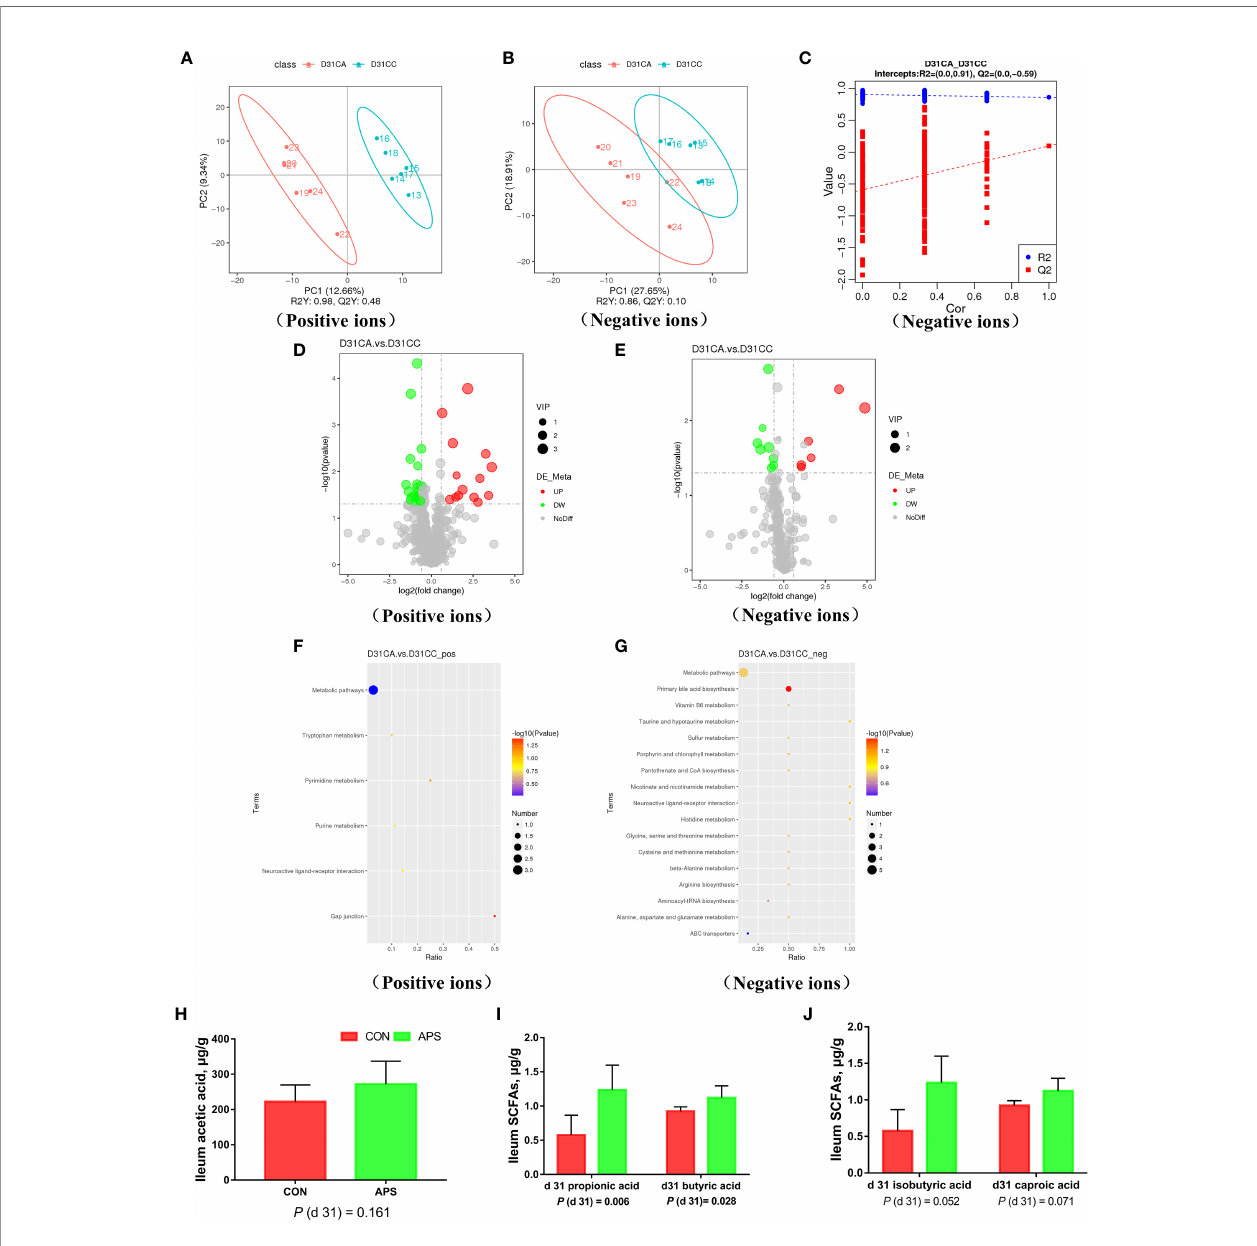
FIGURE 8 | Effects of dietary supplementation of astragalus polysaccharides on ileal metabolome and short-chain fatty acids of broiler chickens. PLS-DA scatter plot for group CA group vs. CC group (A, B) . Permutation test (C) of PLS-DA model for group CA versus CC (negative ion mode). Volcano plot for group CA versus CC (D, E) . Each point in the mountain chart represents a metabolite, the abscissa represents the fold change (take the log 2 logarithm) of each substance in the group, and the ordinate represents the P-value of the T test (take the log 10 logarithm). The size of the scatter points represents the VIP value of the PLS-DA model, and the larger the scatter point, the greater the VIP value. Scattered colors represent the fi nal screening results. Signi fi cantly up-regulated metabolites are shown in red, signi fi cantly down-regulated metabolites are shown in green, and non-signi fi cantly different metabolites are shown in grey. CA group versus CC group KEGG pathway enrichment analysis bubble chart (F, G) . According to the results of KEGG enrichment, select the top 20 pathways sorted by P-values from small to large to draw a bubble chart. The abscissa is x/y (the number of differential metabolites in the corresponding metabolic pathway / the total number of metabolites identi fi ed in the pathway), the larger the value, the higher the enrichment of differential metabolites in the pathway, and the ordinate is the KEGG pathway name. The ordinate and color of the bubble indicate the P-values of the enrichment analysis (take the negative common logarithm, ie -log 10 P-values). The redder the color, the smaller the P-values, indicating that the degree of enrichment is more signi fi cant, the reliability of the test is greater and the difference in statistics is more signi fi cant. The size of the dot represents the number of different metabolites in the corresponding pathway. The larger the dot, the more differential metabolites in the pathway. The levels of short-chain fatty acids (H – J) in the ileal contents of broiler chickens were analyzed by high performance liquid chromatography (Dionex, USA). All graphs are presented as mean, with the standard deviation (SD) shown via the whiskers. Statistical differences were determined by one-way ANOVA, with the P values for the main effects written out below each plot. P-values represent the effect of the APS. CA, dietary APS supplementation group; CC, control